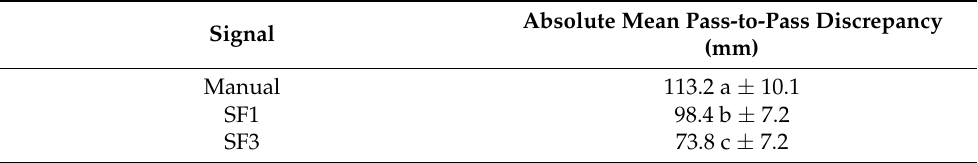
Table 5. Fishers Least Significant Difference (LSD) comparison of Manual harvesting versus SF1 and SF3 signal